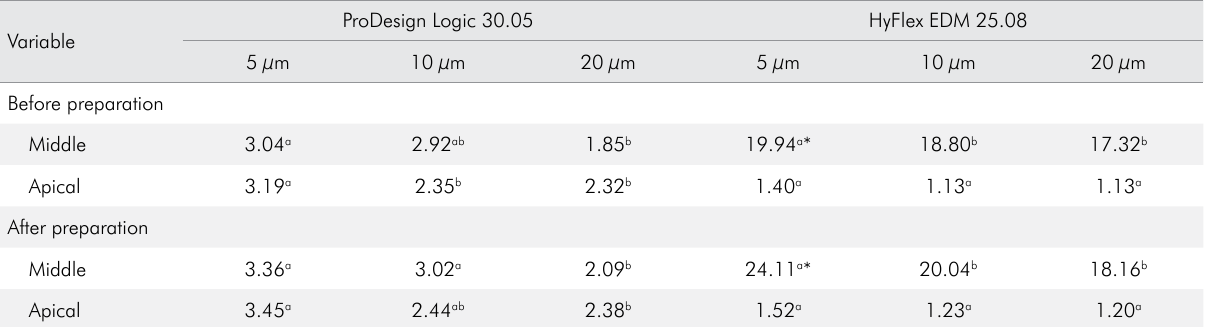
Table. Percentage of sections with dentinal microcracks before and after preparation, based on different voxel sizes.